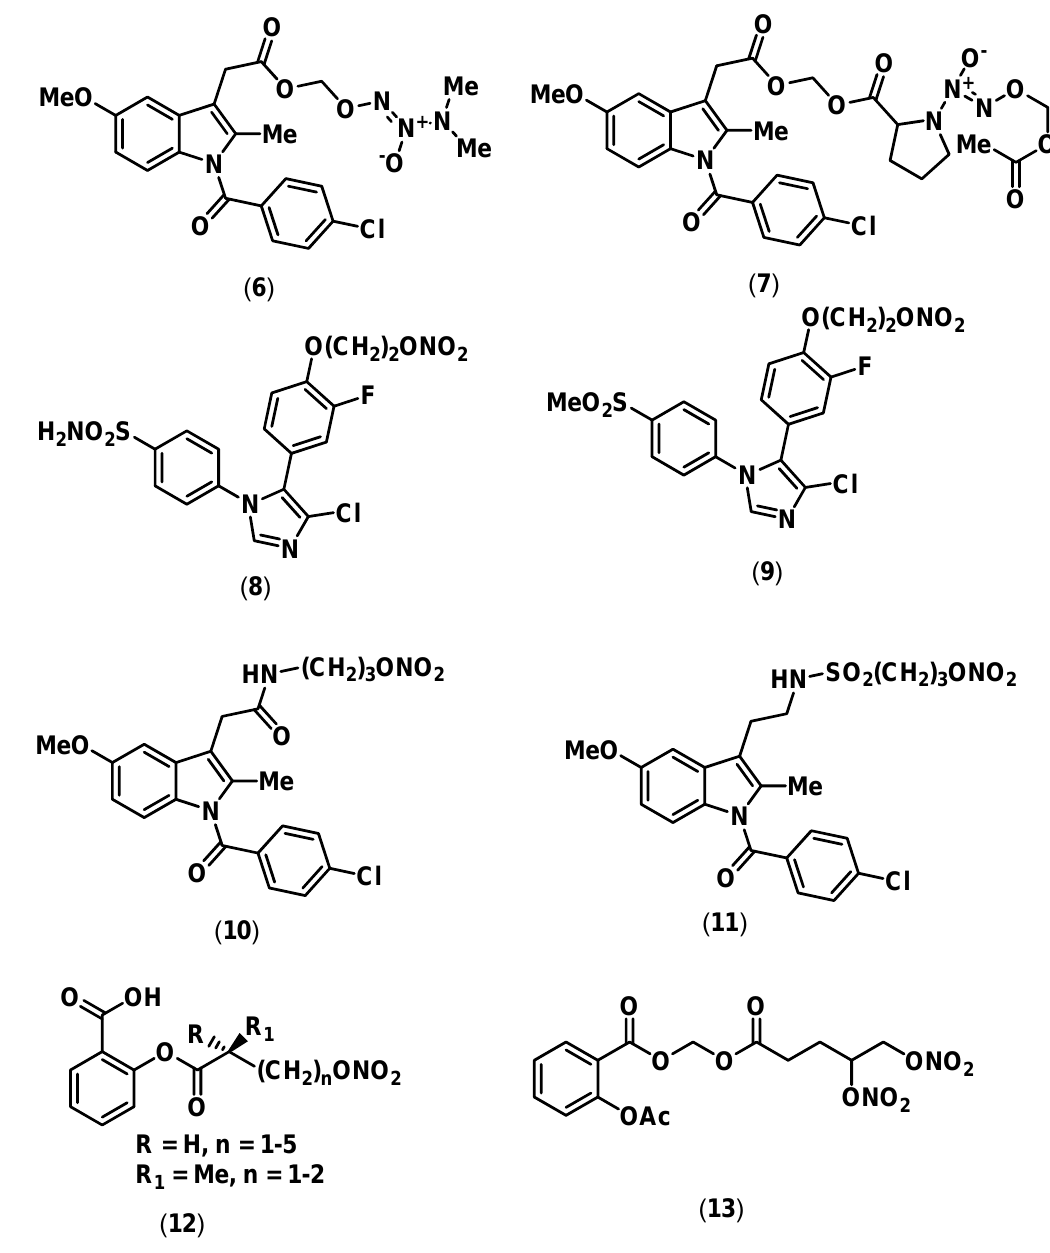
Figure 3. Chemical structures of some representative NO-donor anti-inflammatory